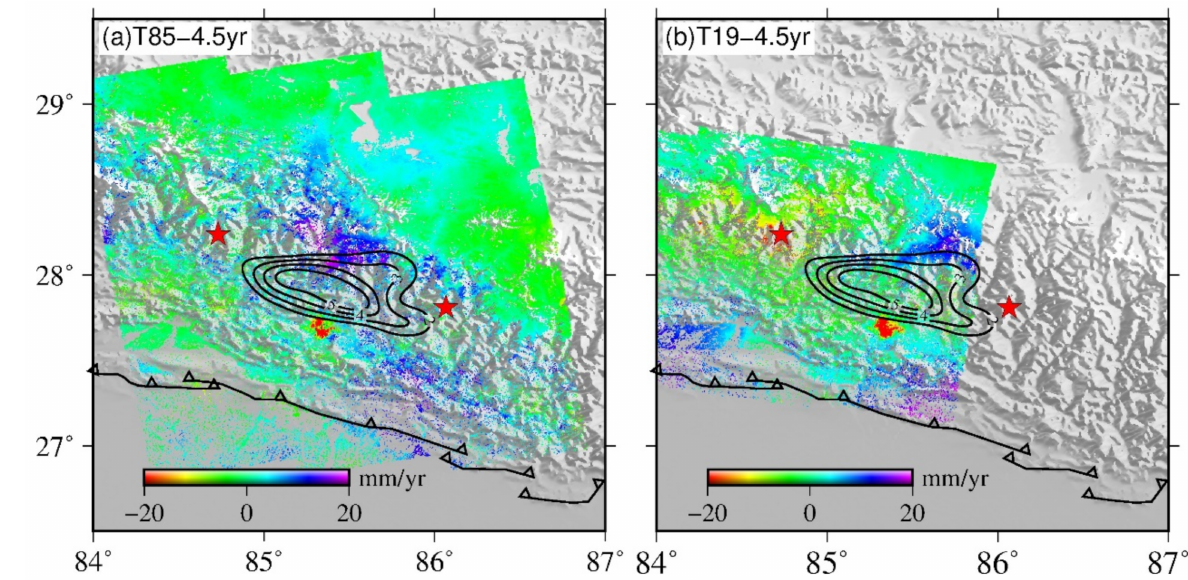
Figure 10. The average velocity field in 4.5 yr after the mainshock derived from the Sentinel-1 data based on PS-InSAR; ( a ) measured by the ascending orbit T85; ( b ) measured by the descending orbit T19; the red star represents the epicenter of the Mw 7.8 and Mw 7.3 earthquakes; the black contour-line represents the co-seismic slip; the black line represents the surface trace of the